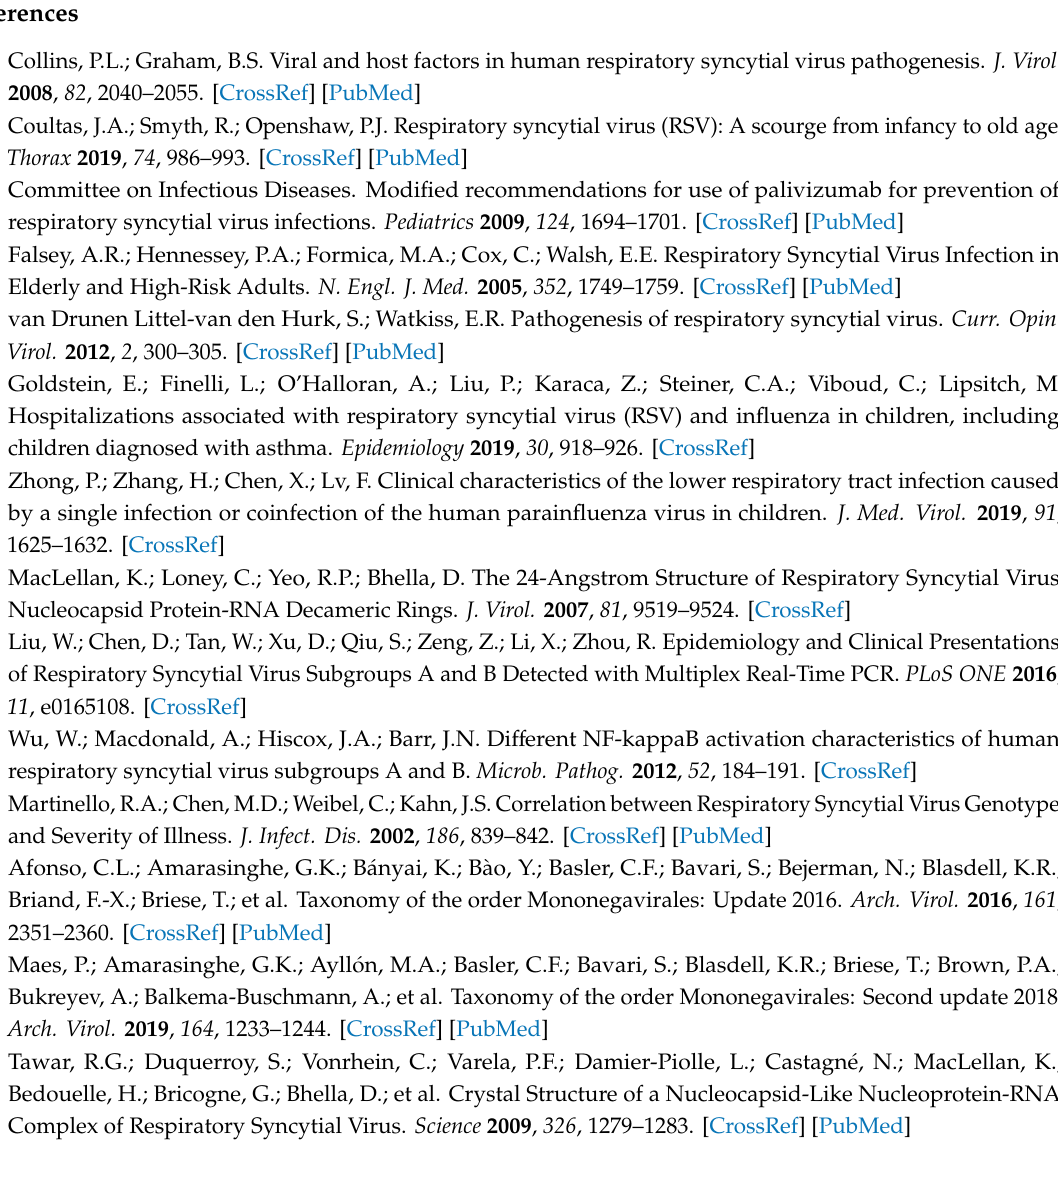
Table S1: ANOVA Comparison of